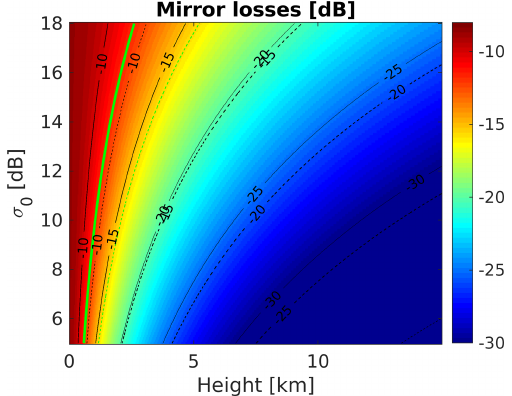
Figure 1. Mirror loss factor derived from Eq. (1) as a function of H t ( x axis) and σ 0 ( y axis) for the EarthCARE (colour shad- ing and continuous black contour lines) and the CloudSat (dashed black contour lines) 94GHz cloud profiling radars for a water sur- face at 10 ◦ C ( (cid:48) = 0 . 608). Values of H sat equal 400 and 705km and those of θ 3dB equal 0.095 ◦ and 0.1085 ◦ and have been used for the EarthCARE and CloudSat configuration, respectively. The contin- uous (dashed) green line corresponds to the values where the two addends in the denominator of the third term on the right-hand side of Eq. (1) are equal for the EarthCARE (CloudSat)